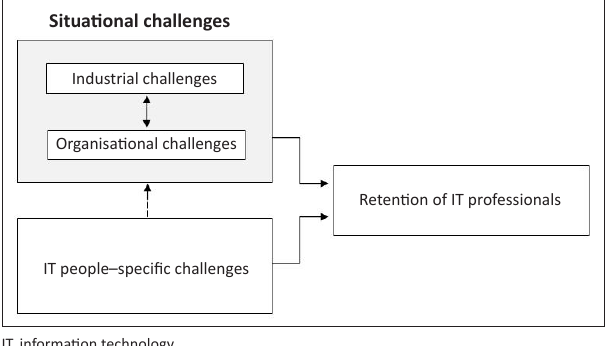
FIGURE 1: Challenges impacting the retention of information technology